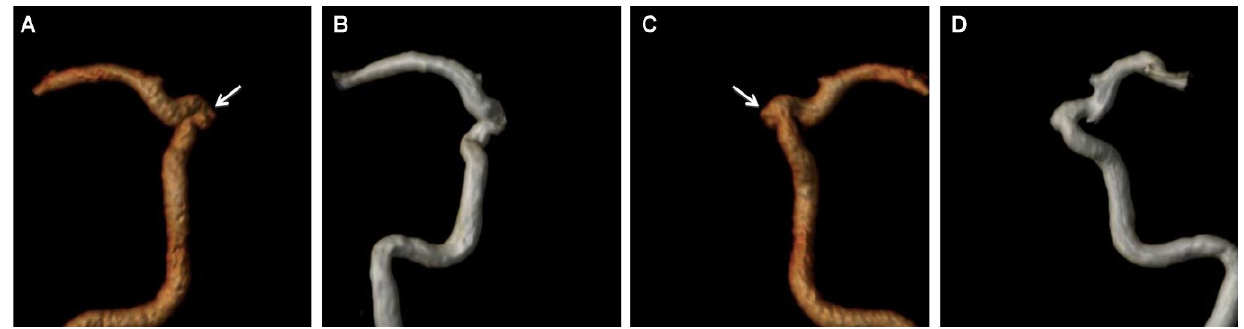
Figure 2 - An internal carotid artery aneurysm with a small neck remnant identified by DSA and CE-MRA but not visible on TOF-MRA. A, B: CE-MRA, with volume-rendered reconstruction of the internal carotid artery, showing a small aneurismal neck remnant (arrow). C, D: TOF-MRA, with volume-rendered reconstruction of the internal carotid artery, without clear identification of the aneurismal